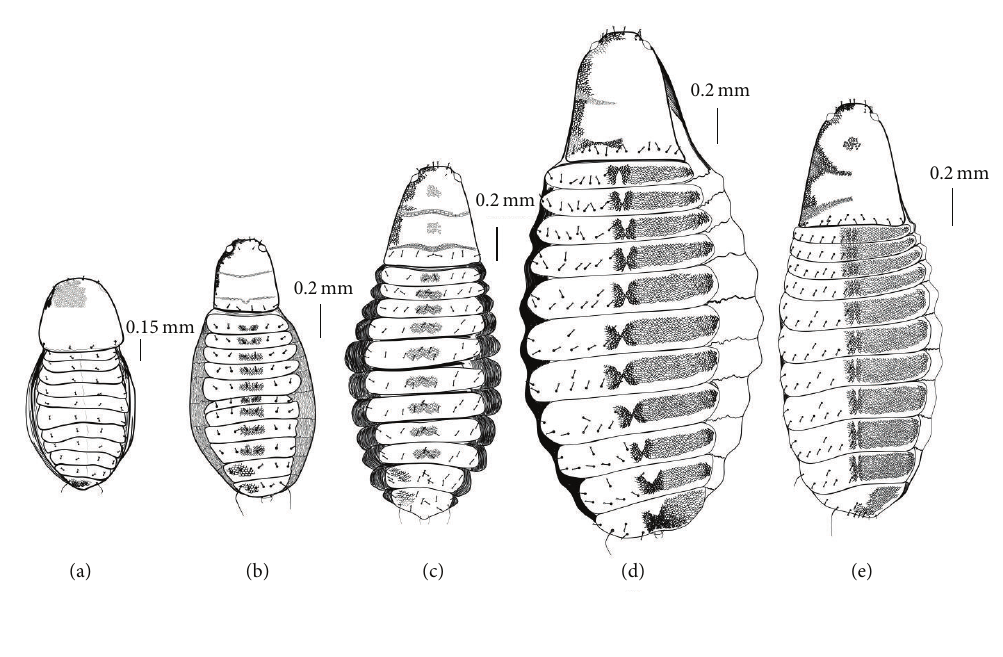
Figure 8: Ventral view of body: (a) protonymph, (b) deutonymph, (c) tritonymph, (d) female, and (e) male.